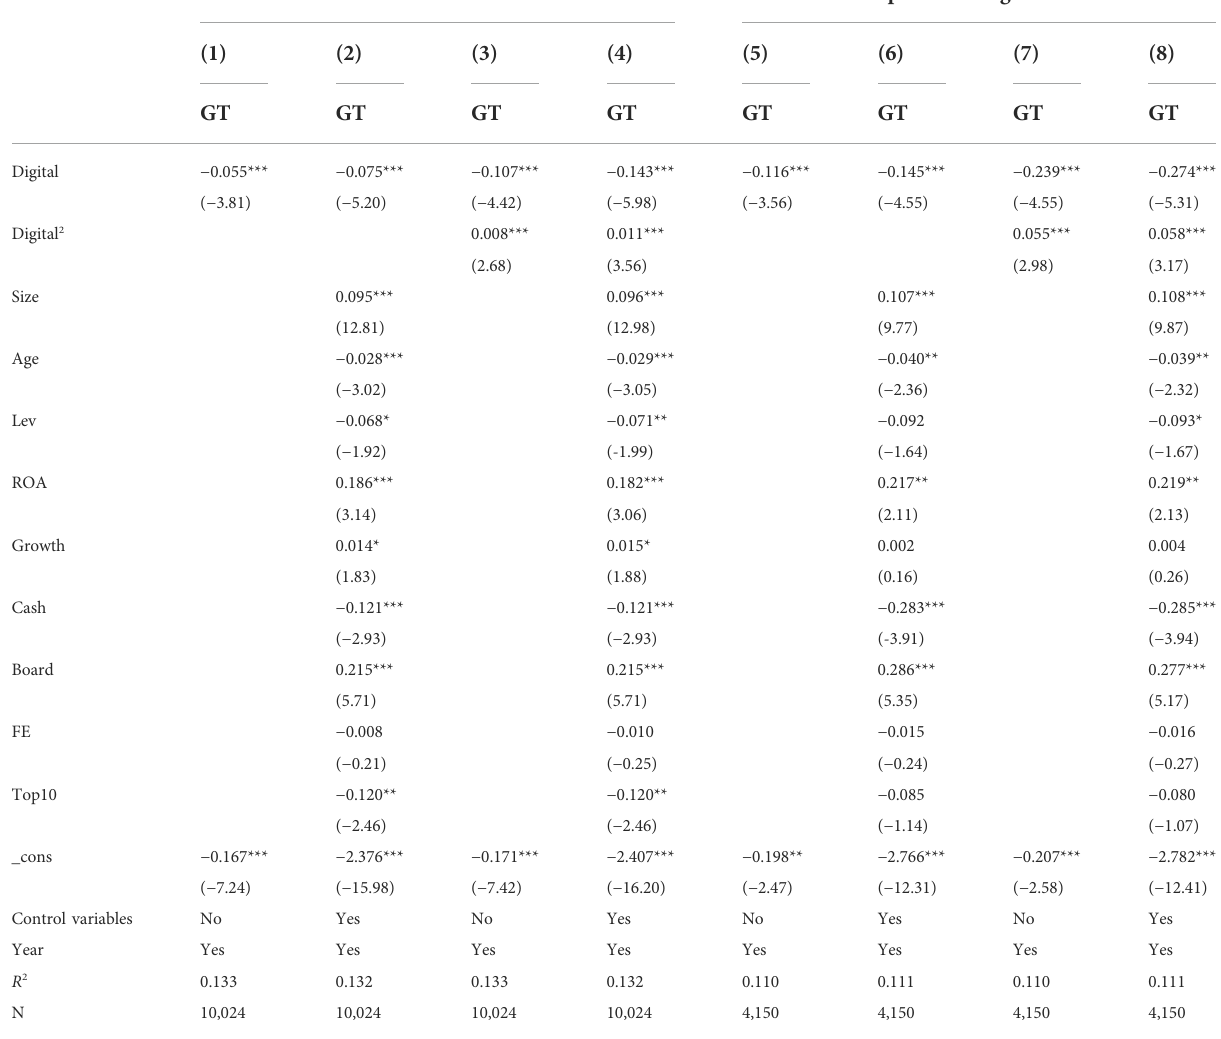
TABLE 4 Baseline test and PSM post-match